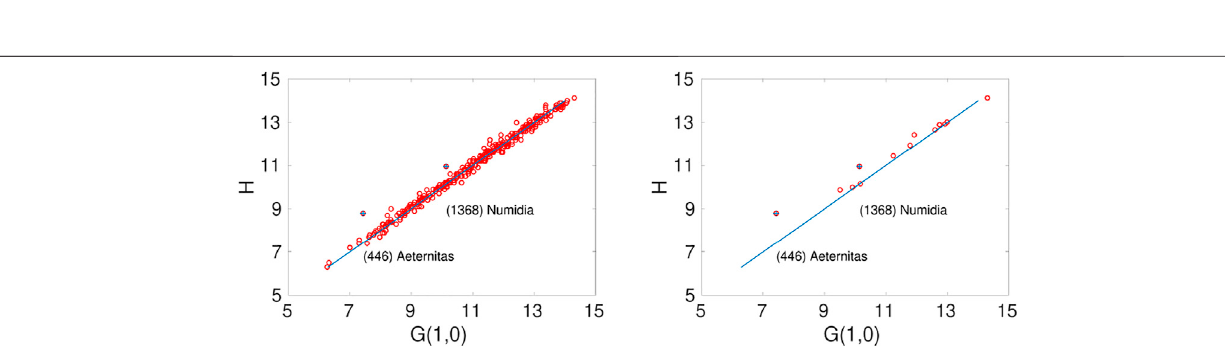
FIGURE 5| The topmost graphs depict σ β as afunction of β S (20 ° ) using 358asteroids (left) and highlighting 13new asteroids presently processed (right). The S ( 20 ° ) as a function of β S (20 ° ) for 97 asteroids with known Tholen classes (left), highlighting six new asteroids (right). The bottom graphs provide a middle graphs show σ β S ( 20 ° ) zoom-in of the middle graphs.